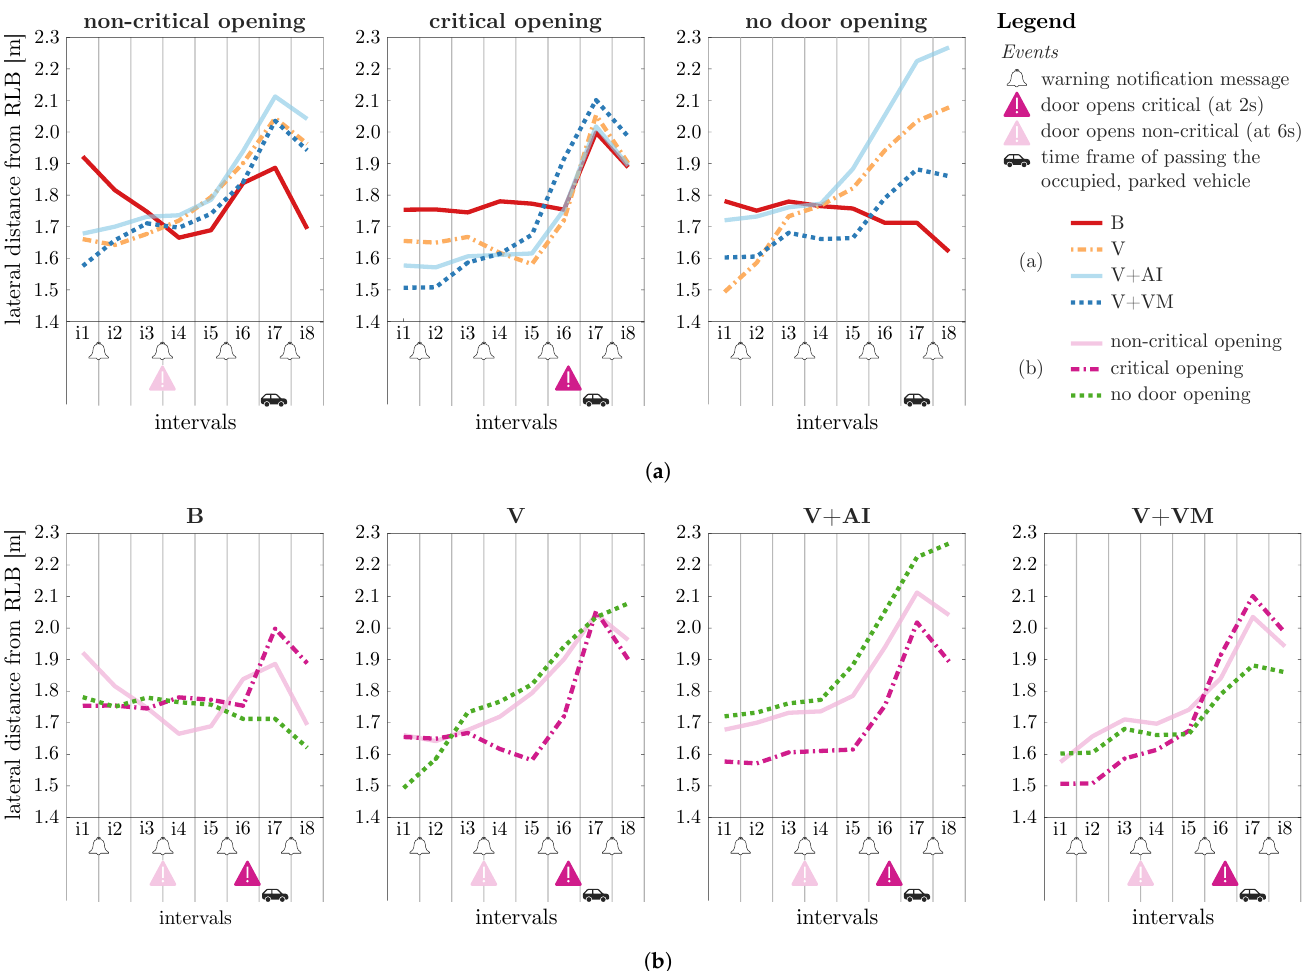
Figure 5. Lateral distance profiles: in ( a ), per condition with one plot per door opening type , and in ( b ), per door opening type with one plot per condition . Further, the time points when AMs show up are highlighted at 9, 6, 3, and 0 s by a notification icon. Whether a door opens is indicated by a small warning sign (light pink for non-critical situations (at 6 s), and dark pink for critical situations (at 2 s)). The time interval of passing the vehicle is indicated with a car icon at